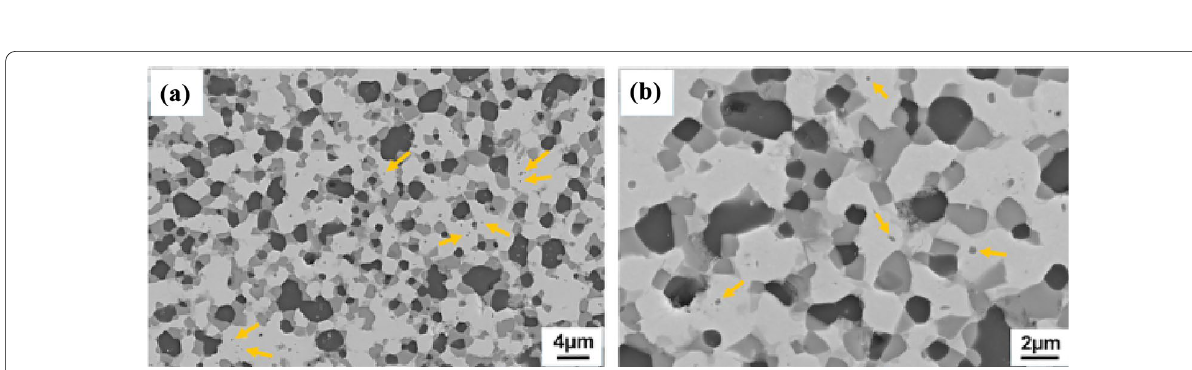
Figure 6 Microstructures of the as-sintered CrMoNbWTi–CNO RHEA: SEM micrographs at ( a ) low magnification and ( b ) high magnification